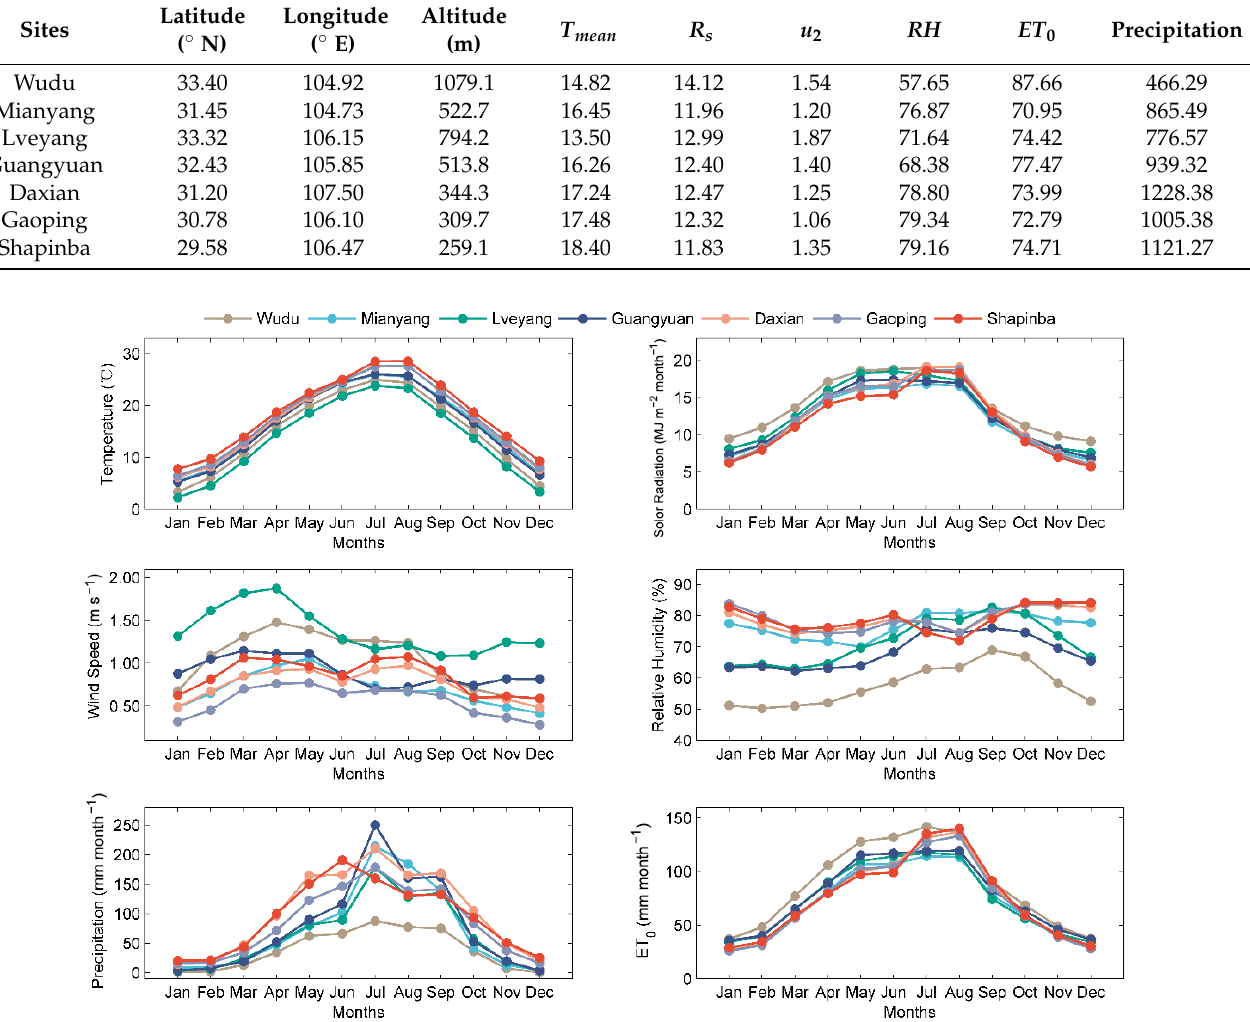
Table 1. Meteorological stations with monthly average climatic conditions (from 1964 to 2014).